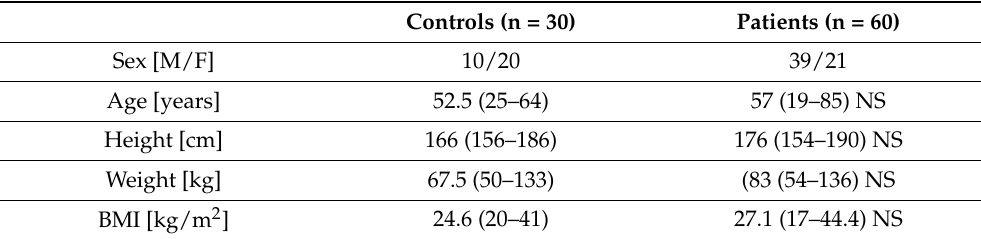
Table 1. Baseline characteristics of patients and controls.